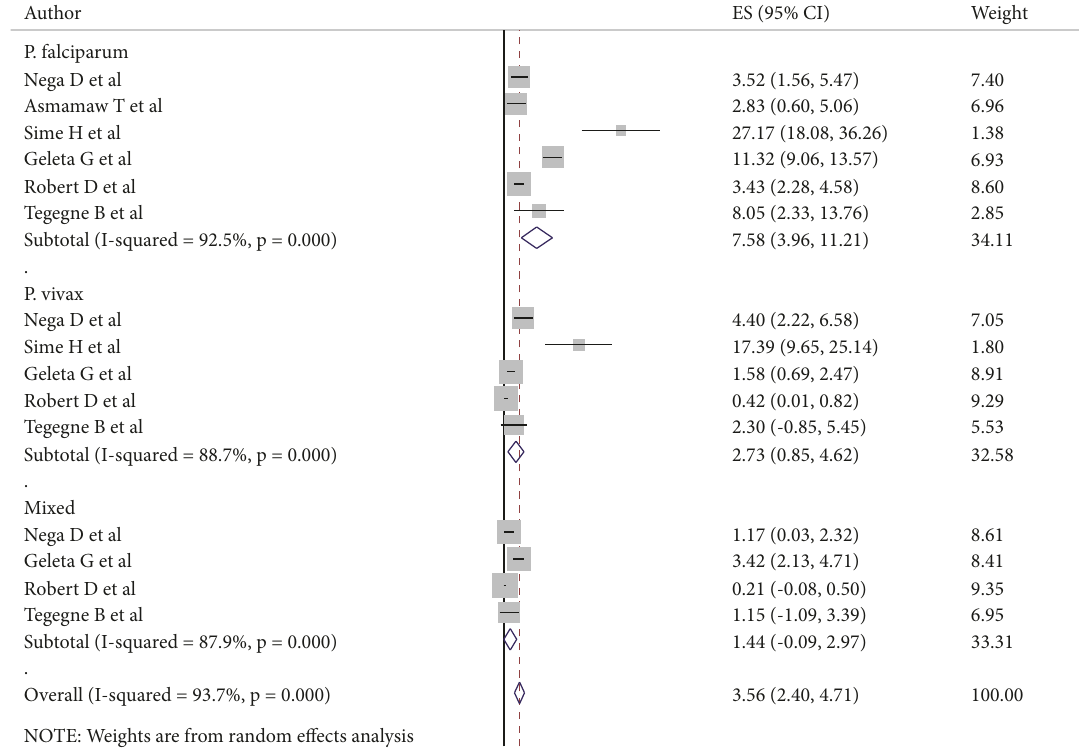
Figure 3: The pooled estimates of the prevalence of malaria among pregnant women from random effect model by the type of Plasmodium species. The midpoint and the length of each segment indicated prevalence and a 95% CI, whereas the diamond shape showed the combined prevalence of all studies.